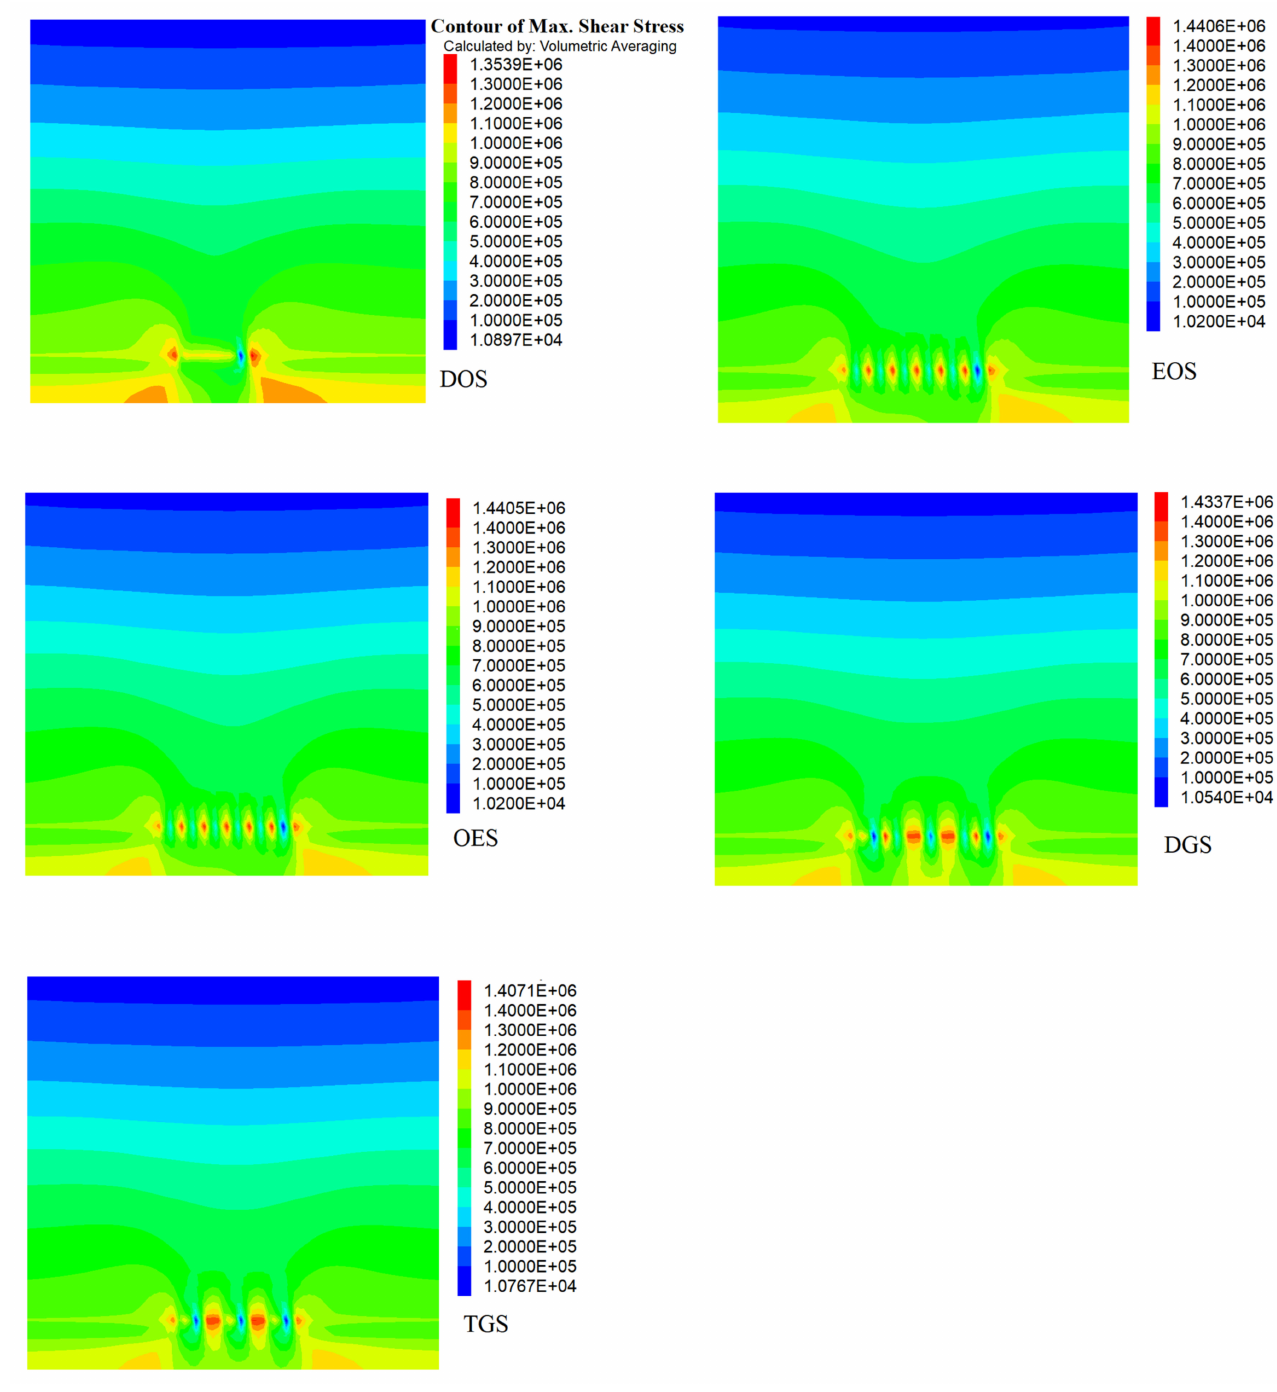
Figure 10. Contours of maximum shear